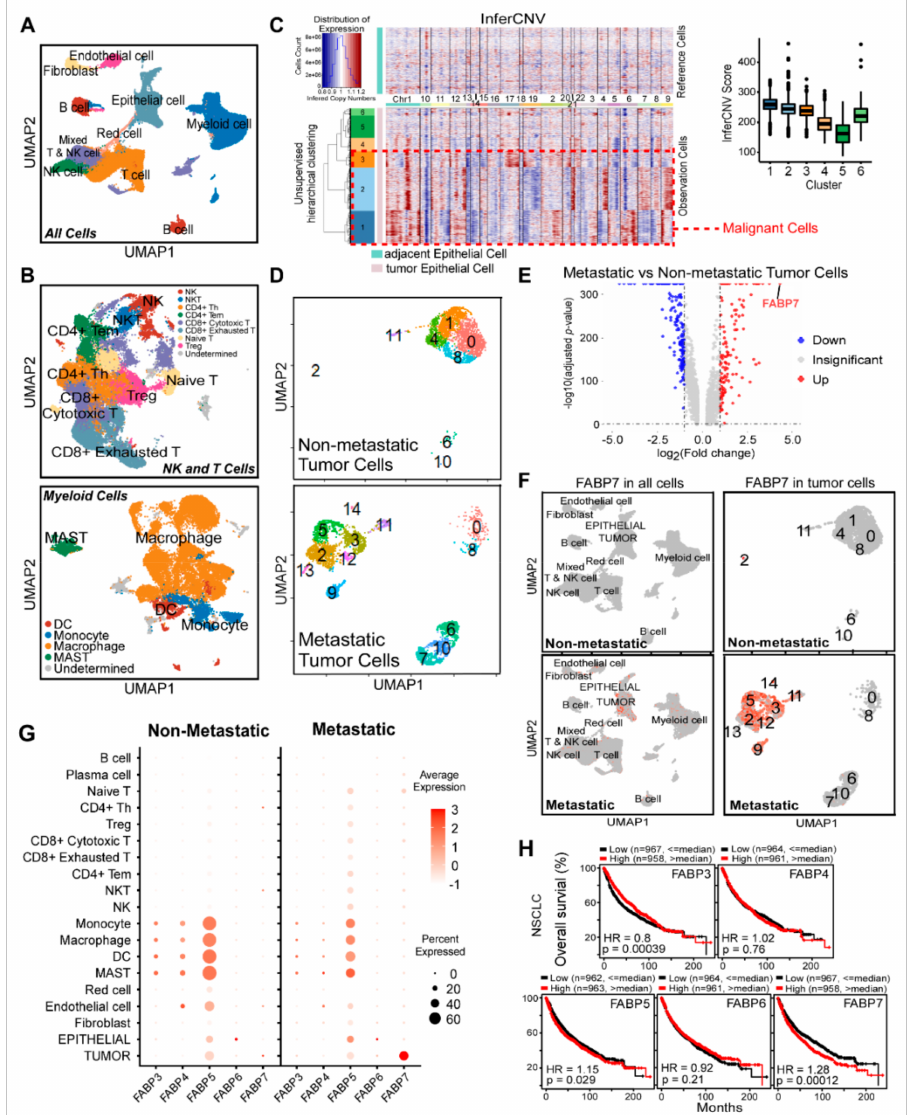
Figure 1. FABP7 is highly expressed in NSCLC cells. ( A ) UMAP visualization of all cells in the single-cell dataset colored by identified cell types. ( B ) UMAP visualization of NK and T cells (top) and myeloid cells (bottom) in the single-cell dataset colored by identified cell types. ( C ) Identification of tumor cells. Inferred copy number variations (CNVs) patterns of each chromosome (shown by different color bars) were compared between normal cells (Reference Cells) and epithelial cells from tumor tissues (Observation Cells). A higher inferCNV score (right) represents a higher CNVs degree of the cluster. The red dash line box shows malignant cells with obvious CNVs and higher inferCNV scores. ( D ) UMAP visualization of tumor cells from non-metastatic (top) or metastatic (bottom) patients. ( E ) Volcano plot of differentially expressed genes (DEGs) between tumor cells of metastatic and non-metastatic patients. Expressions with adjusted p -value < 0.05 are shown in red (log 2 Fold change > 1) or blue (log 2 Fold change < − 1), while those with adjusted p -value > = 0.05 are shown in grey. ( F ) FABP7 Expression of all main cell types (left) or tumor cells (right) split by patients with or without metastasis. Expression levels of FABP7 are labeled by the intensity of red color. ( G ) Average expressions of FABP3-7 in indicated cell types split by patients without (left) or with (right) metastasis. ( H ) Kaplan-Meier overall survival (OS) analyses of FABP3-7 in NSCLC based on KM-plotter. To uncover the unique molecular mechanism that endows tumor cells to metastasize, 5880 malignant cells were further clustered into 15 subclusters, where cells from